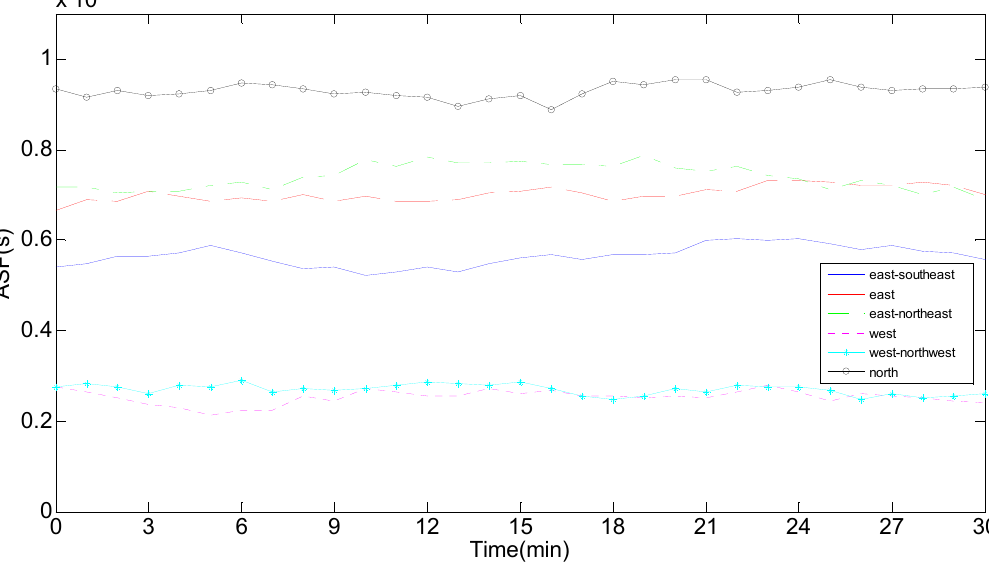
Figure 14. ASF values changing with different wind direction conditions.